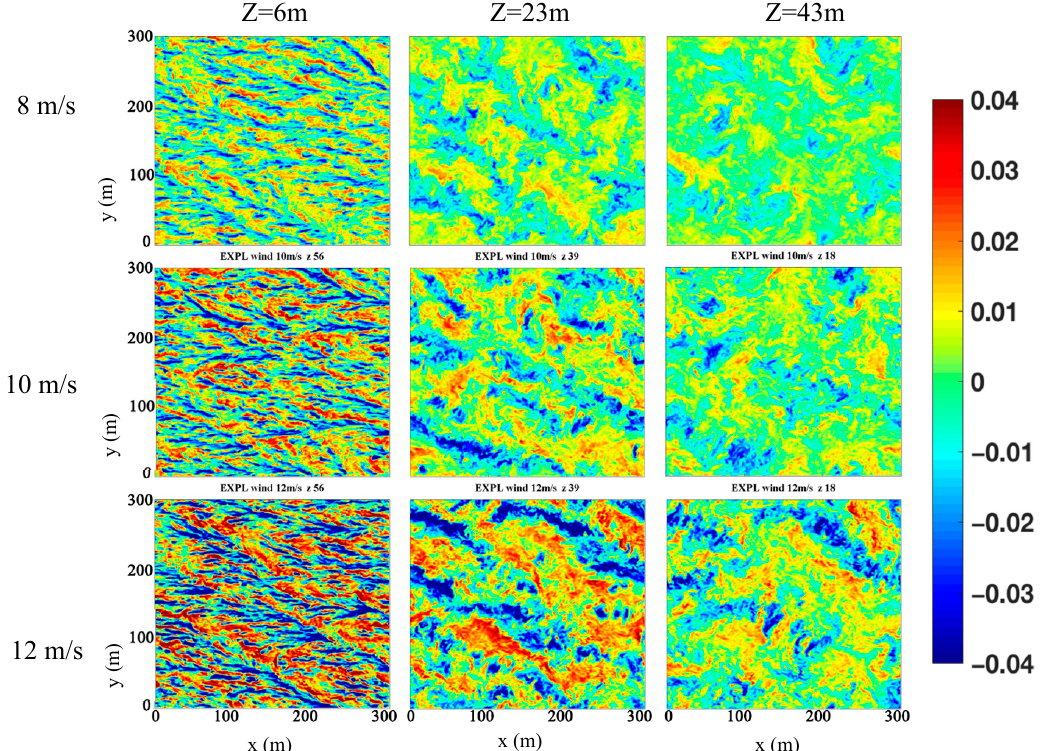
Figure 5. Horizontal cross-section of vertical velocity (m/s) at 6 m (z56), 23 m (z39) and 43 m (z18) for EXP WIND L under different wind speed conditions (U = 8, 10 and 12 m/s).